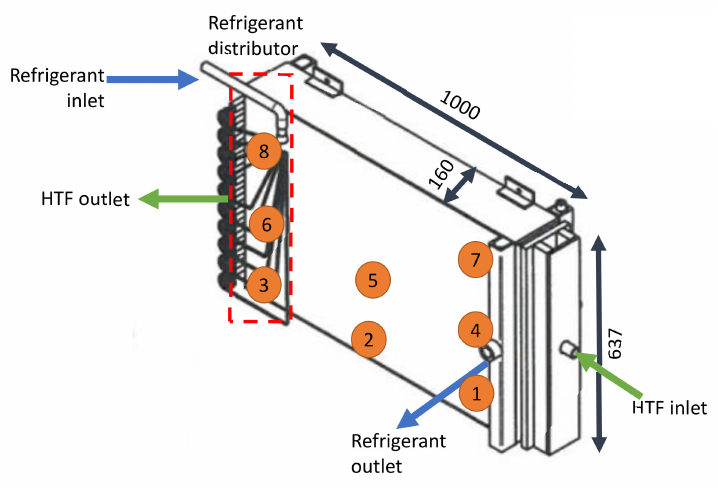
Figure 4. 3D view of the RPW-HEX and position of sensors and inlet/outlet